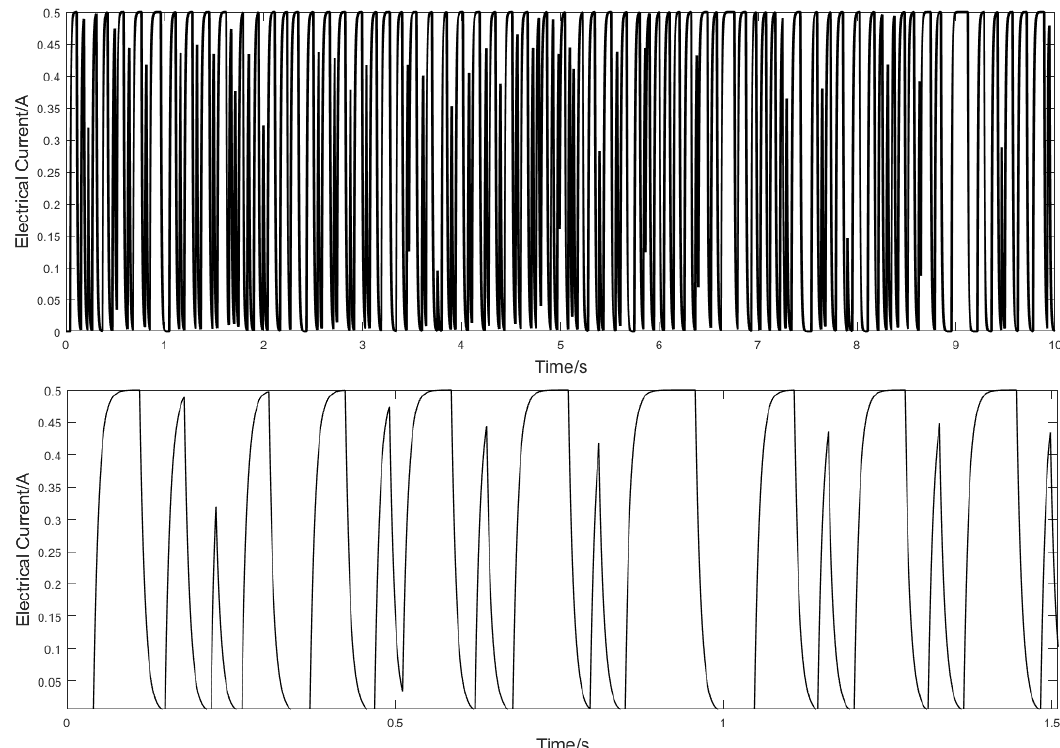
Figure 12. Control signal generated by the empirically tuned BELBIC. The top plot regards a total time of 10 s and the bottom plot, a narrower interval.